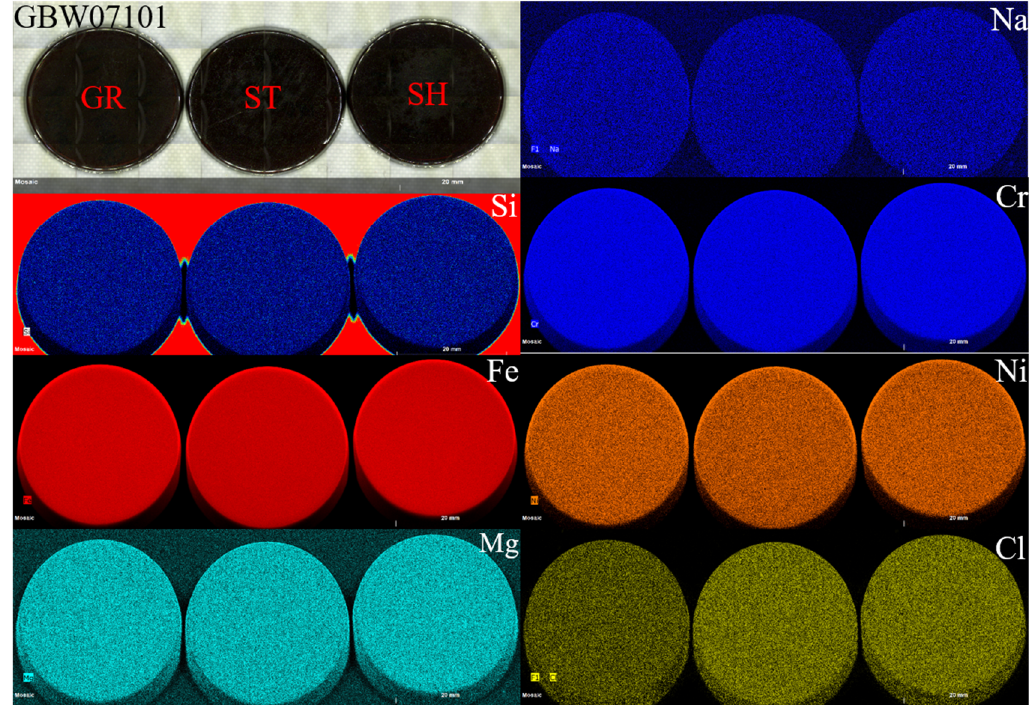
Figure 2. Mapping images of the GBW07101 (ultramafic rock) samples [Scanning area: width, 4645 pixels (92.9 mm) and height, 1615 pixels (32.3 mm); counting time per pixel (20 μm), 5 ms].